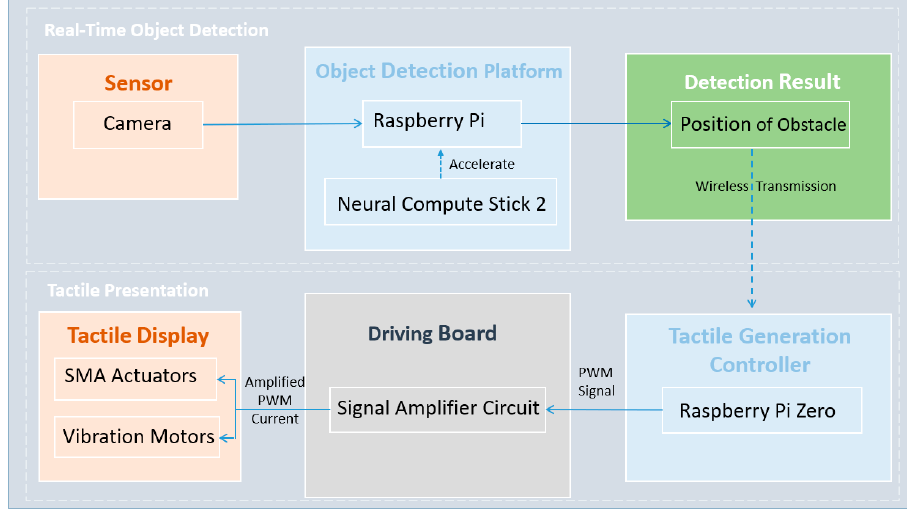
Figure 1. Constructure of the wearable device.